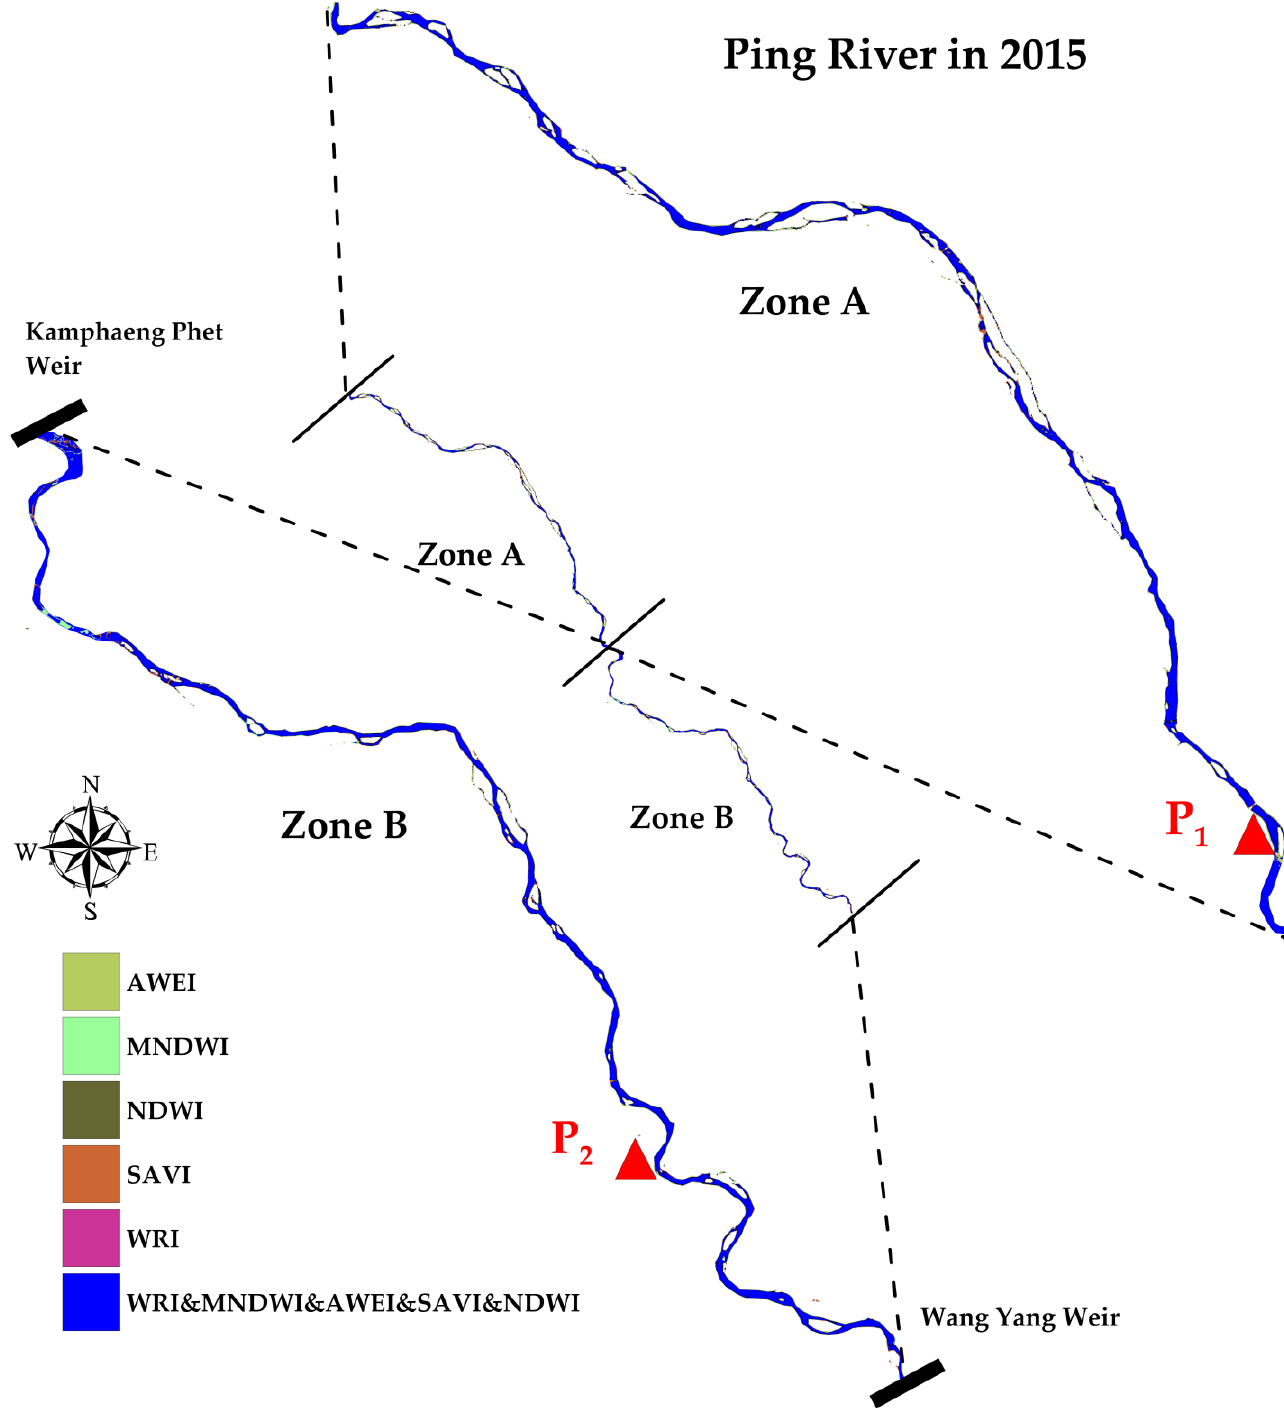
Figure 10. An overlay stream exists between NDWI, MNDWI, SAVI, WRI, and AWEI for 2015; Zone A is the upstream reach, and zone B is the downstream reach.